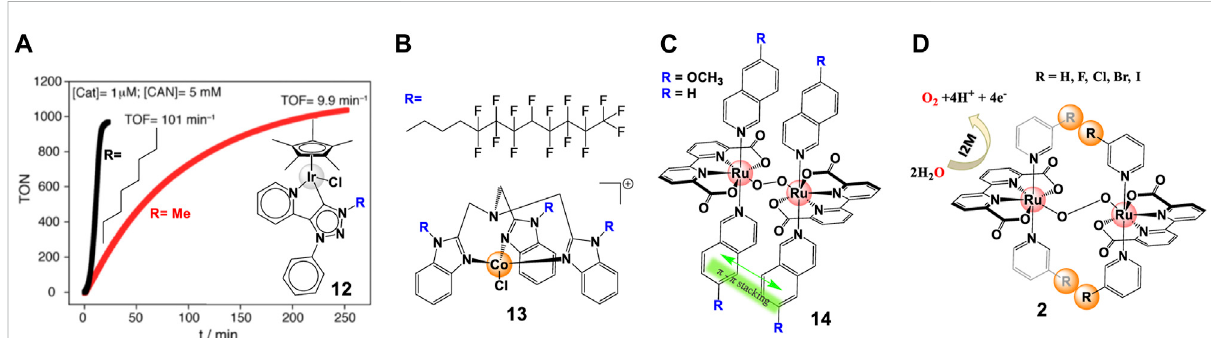
FIGURE 5 (A) TON of complex 12 at pH 1 measured by UV − vis spectroscopy, adapt with permission from ACS Catal. 2015, 5, 5, 2,714 – 2,718. Copyright 2015 American Chemical Society. (B) Chemical structure of complex 13 . (C,D) Schematic diagram for noncovalent interactions between the axial ligands for complex 14 and complex 2 .